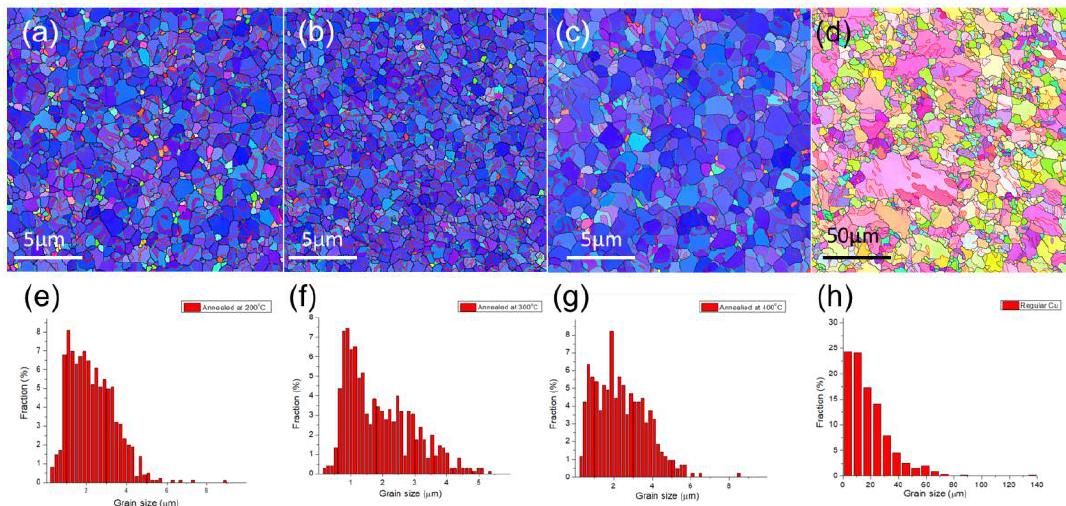
Figure 7. Plan-view grain orientation maps of B-type nt-Cu annealed at ( a ) 200 °C, ( b ) 300 °C, and ( c ) 400 °C for 1 h, and ( d ) 400 °C for 3 h. The low angle grain boundaries, high angle grain boundaries, and twin boundaries are marked in green lines, black lines, and red lines, respectively. ( e ) to ( h ) represent the grain size distribution of the specimen in ( a ) to ( d ). The surface preferred orientation transformed from <111> to random orientation after annealing at 400 °C for 3 h.